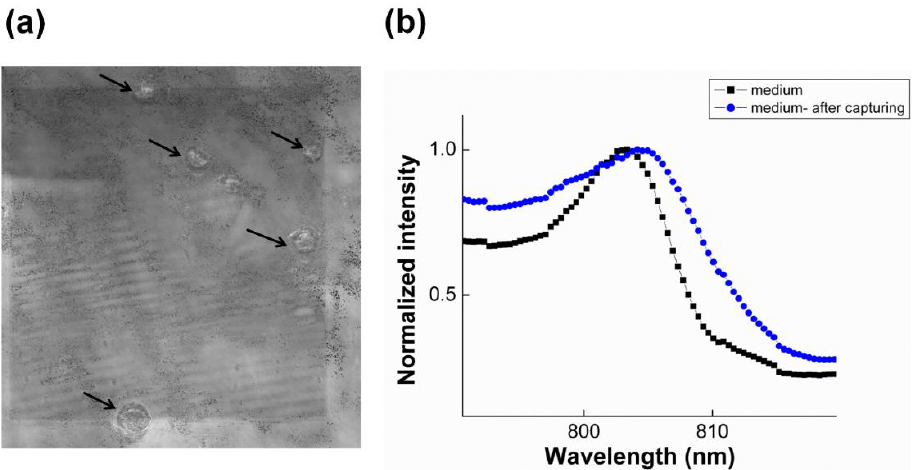
Figure 7. A suspension of 100 cells in 1 mL medium was introduced to the funnel chip integrated with the dual cylindrical magnets with a needle and flow rate of 300 µL·min −1 . ( a ) Microscopy images of the gold nanoslit surface after cell capturing on the detection area and ( b ) SPR response before and after capturing